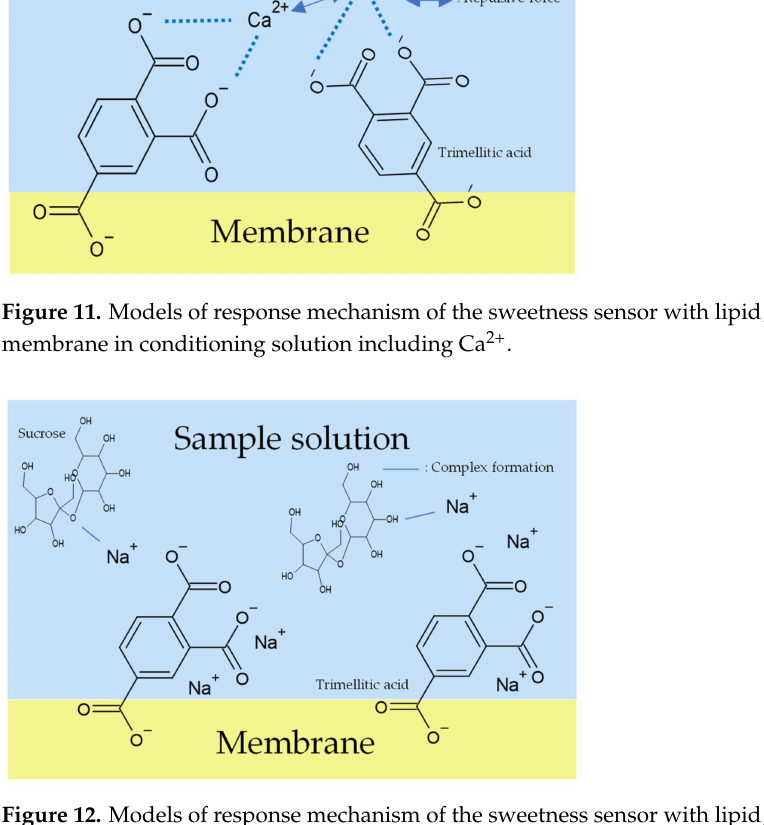
Figure 12. Models of response mechanism of the sweetness sensor with lipid/polymer membranes: membrane in sample